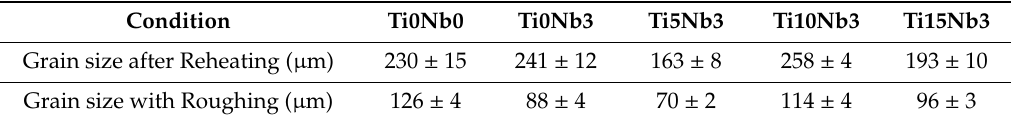
Table 2. Average austenite grain sizes measured for samples quenched for initial microstructure analysis before and after roughing pass application .